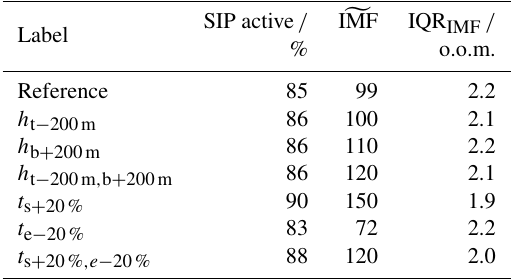
Table F1. Benchmarks of sensitivity studies of obtained secondary ice production (SIP) and ice multiplication factor (IMF) based on data selection for both estimates. The data selection limits in height and time were changed by ± 200m and by ± 20% of the time span,